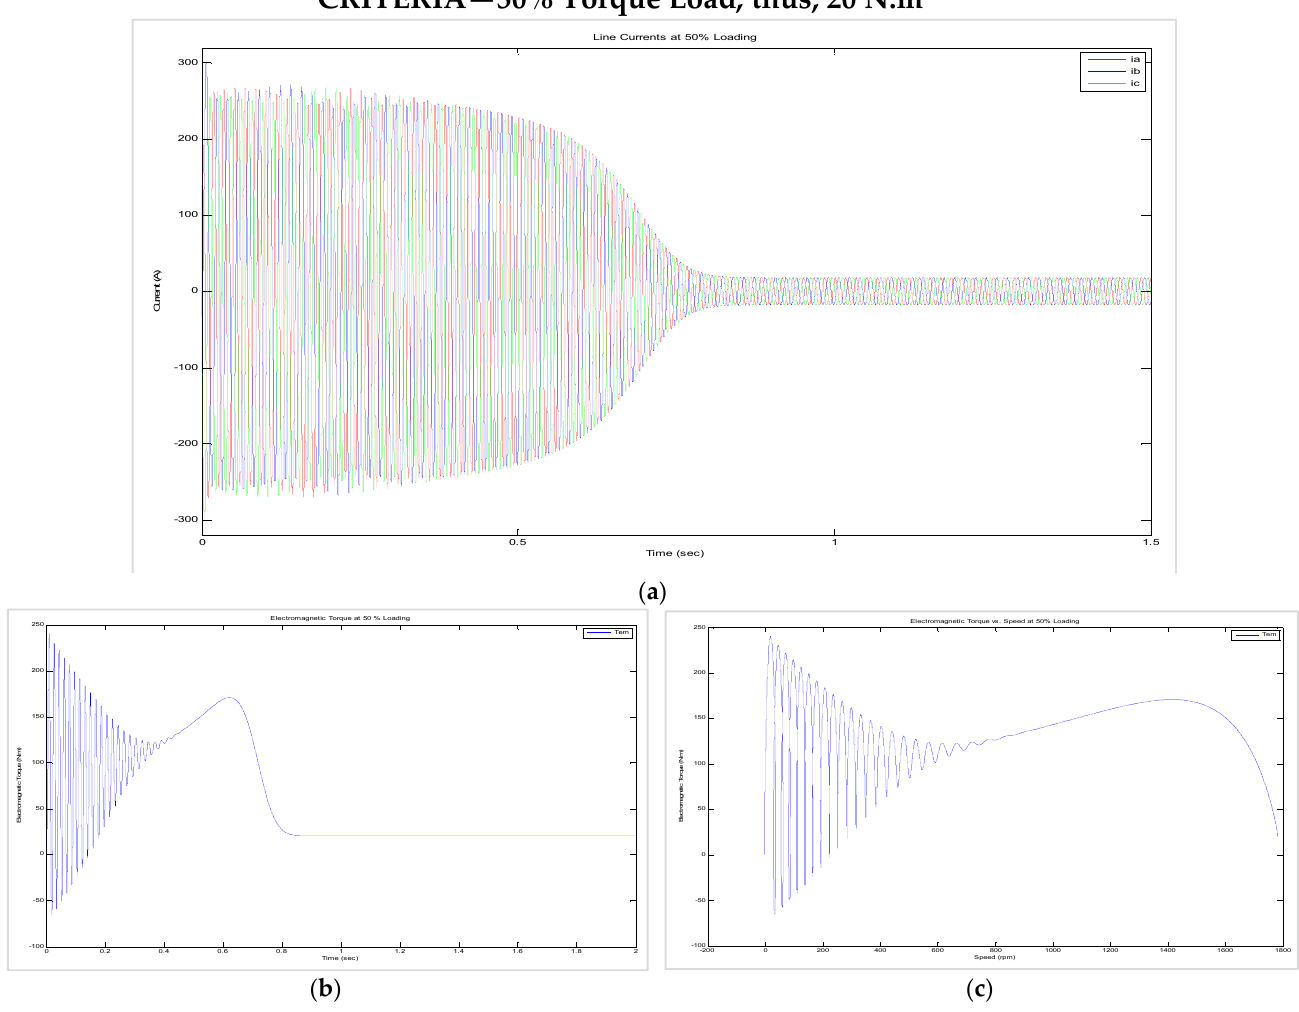
Figure 19. ( a ) Line currents at 50% loading. ( b ) Electromagnetic torque at 50% loading. ( c ) Electro- magnetic torque vs. speed at 50% loading.